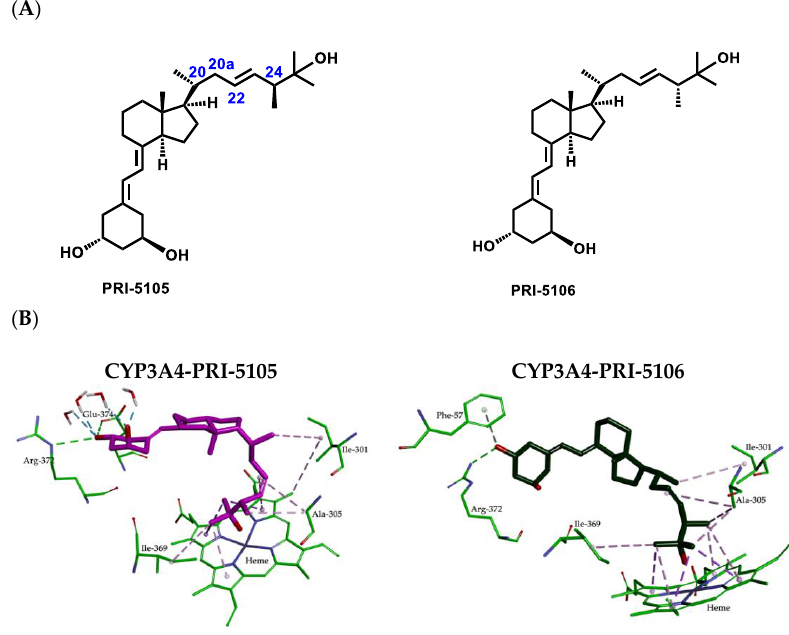
Figure 7. ( A ) Structural formulas the analogs of 1 α ,25-dihydroxyvitamin D 2 (PRI-5105 and PRI-5106). ( B ) Molecular interactions between 1,25D2 analogs (PRI-5105 and PRI-5106) and CYP3A4 resulting from MD simulations. Hydrophobic interactions are shown as magenta dashed lines and hydrogen bonds as green. Compared to PRI-1906, PRI-5201 has the 19- nor modification and the PRI- 5201/CYP3A4 complex showed an extended conformation, as seen for the PRI- 1906/CYP3A4 complex, but the position of 1-and 3-hydroxyls at the A-ring of PRI-5201 formed a very strong hydrogen bond with Asp-76, Arg-106, Arg-372, and three water mol- ecules (see Figures 6 and S1 in Supplementary Materials). This is likely responsible for the higher affinity of PRI-5201, versus that of PRI-1906. 2.4. Metabolic Conversion of 1,25D3 Analogs PRI-1901 and PRI-2205 to hCYP24A1-Mediated Degradation